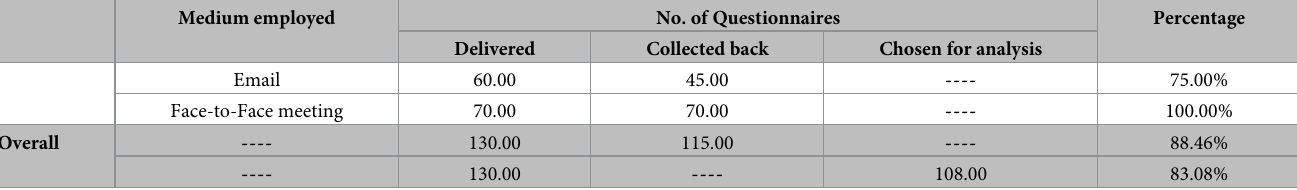
Table 1. Particulars of the 1 st questionnaire survey. Medium